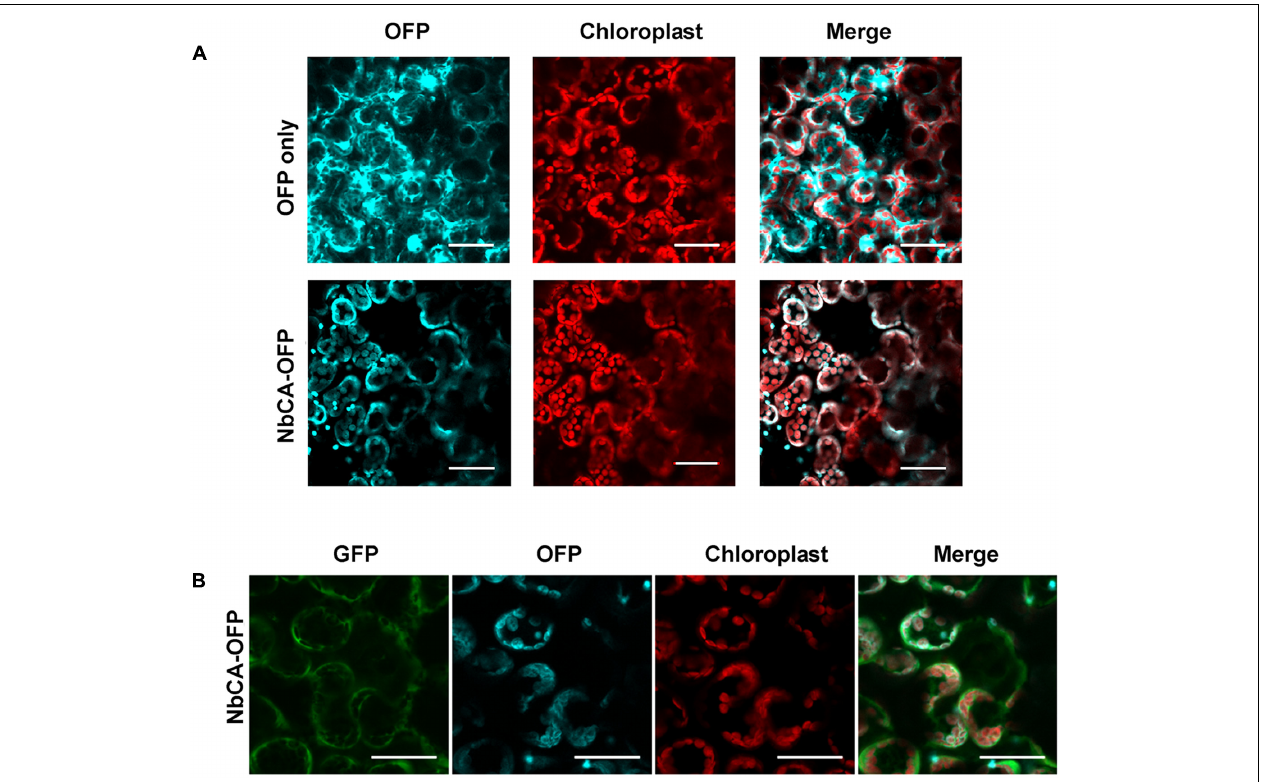
FIGURE 4 | Localization of NbCA in N. benthamiana cells. The pEpyon vector and NbCA-Orange fluorescent protein (NbCA-OFP) constructs were transiently expressed on N. benthamiana leaves by agroinfiltration for 3 days without (A) or with (B) inoculation of BaMV vector carrying a GFP reporter. NbCA-OFP is labeled in cyan and chloroplast is in red. BaMV infection carrying GFP is in green. Images were taken under an Olympus Fluoview FV1000 Confocal Microscope with 488, 543, and 633 nm laser excitations for GFP, OFP, and autofluorescence, respectively. Scale bar: 40 µ